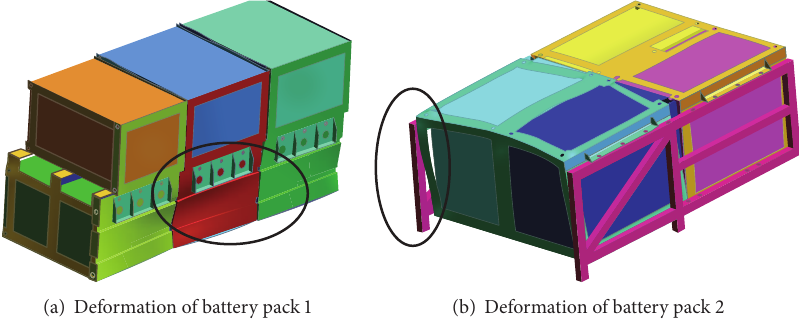
Figure 4: The rear-end collision simulation of battery pack 1 and battery pack